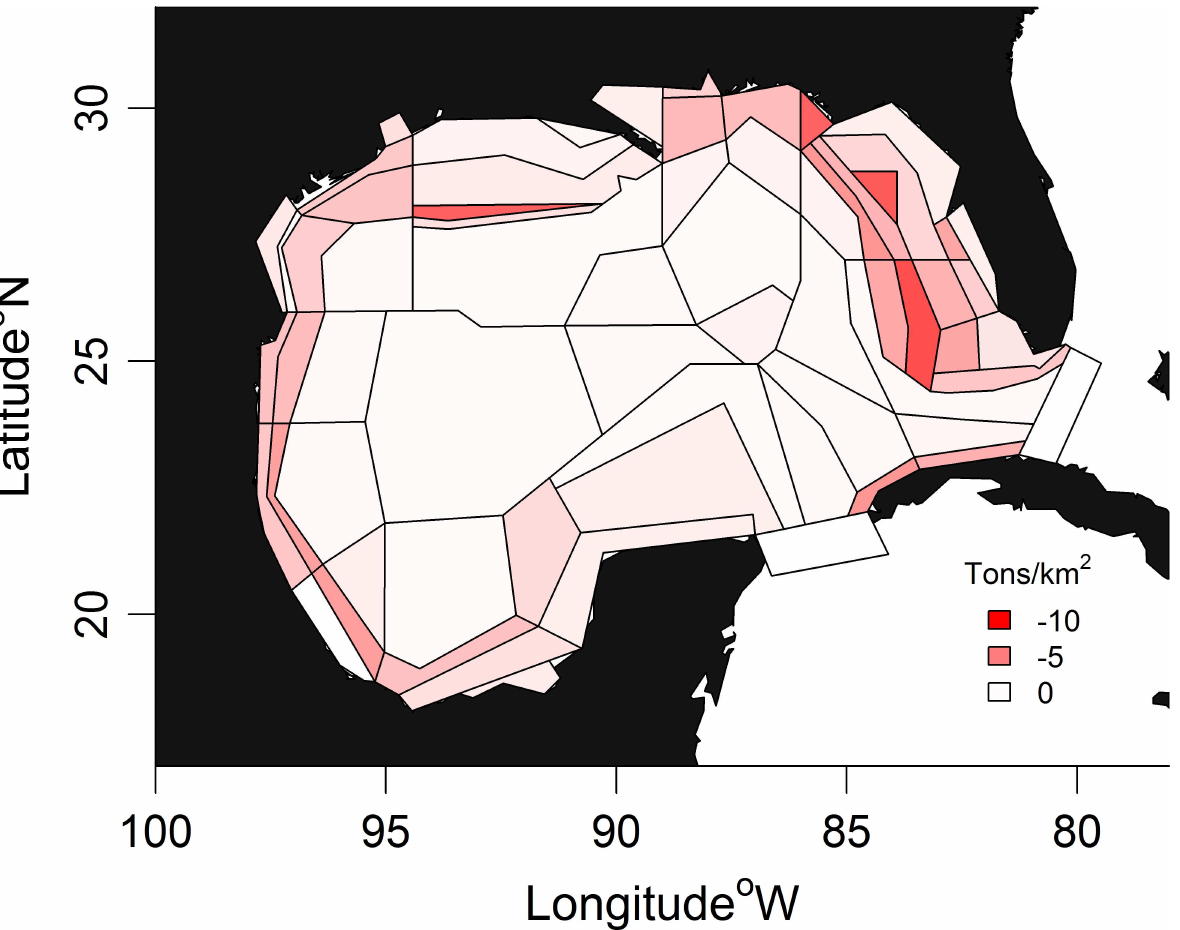
Fig 5. Absolute biomass reduction for no oil versus oil scenario for grouper guild. Biomass minima is shown occurring at 10 months after the oil spill. Oil simulation [K1000 β 363].